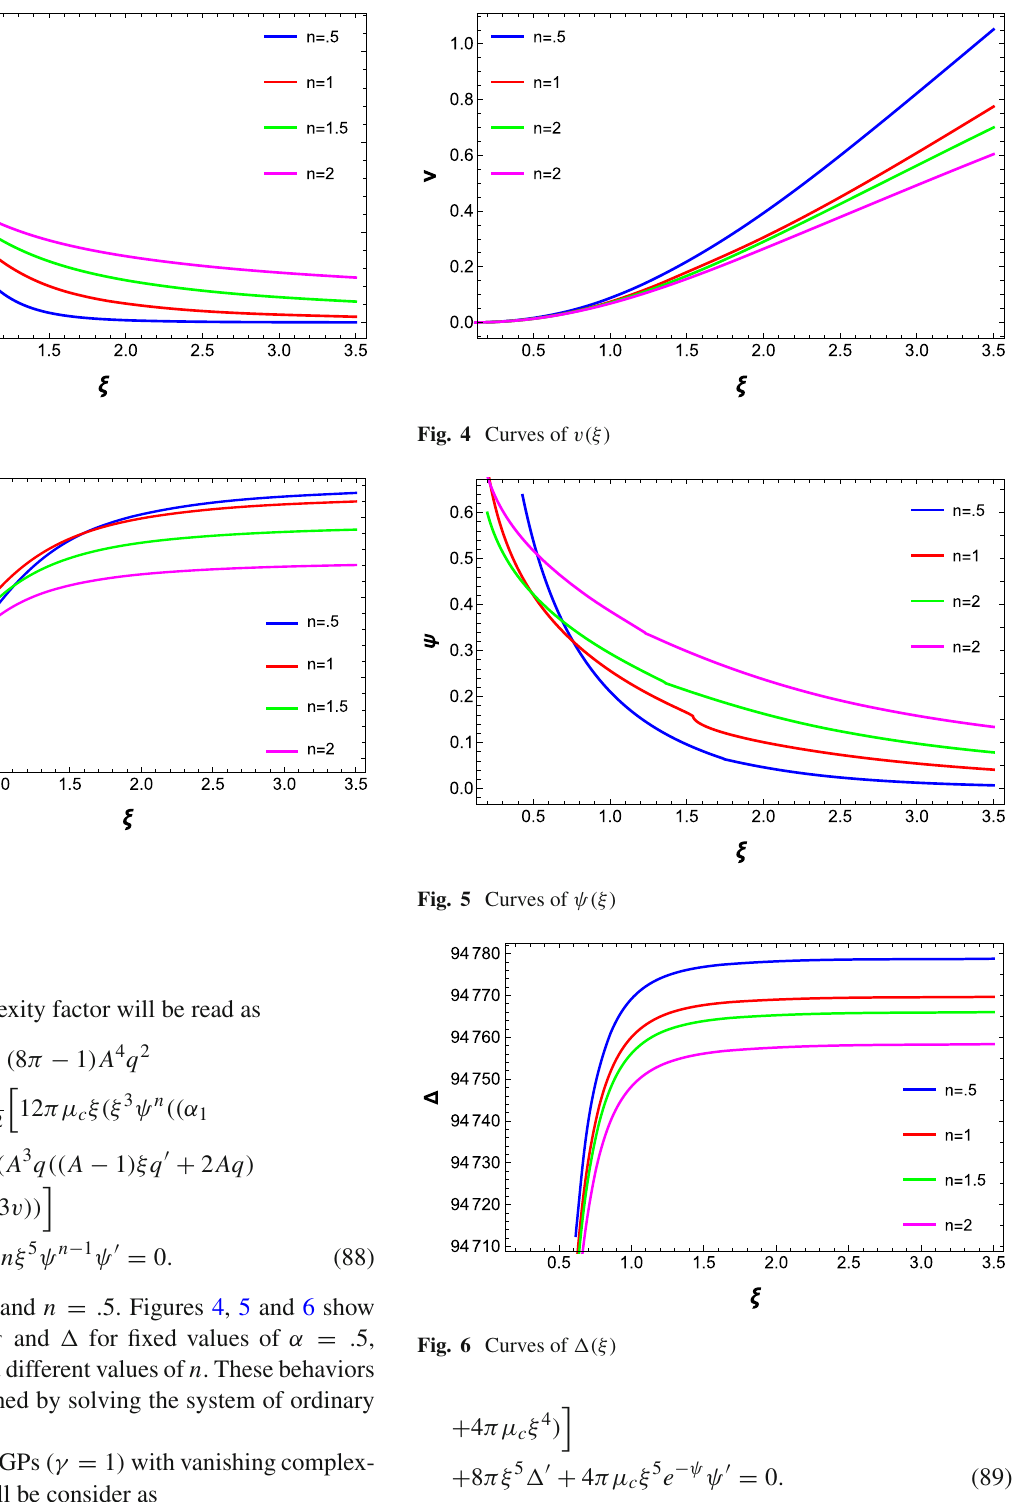
Fig. 4 Curves of v(ξ)